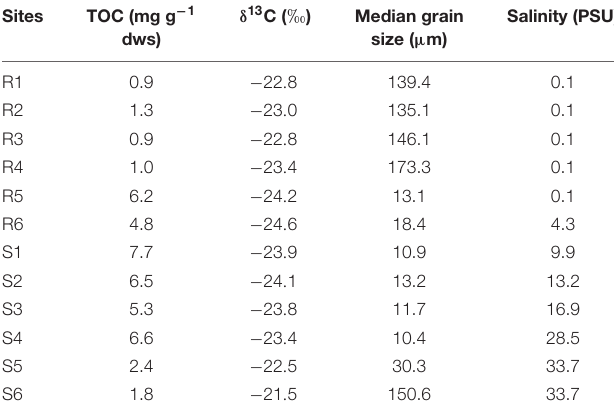
TABLE 1 | Bulk characteristics of surface sediments and overlying surface waters in the Yangtze River-dominated margin.